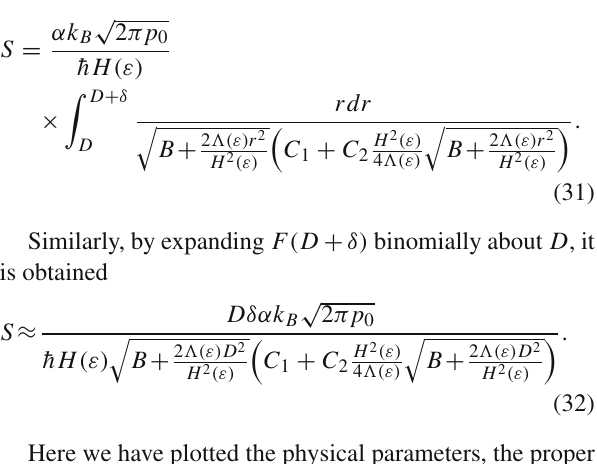
these figures, we see that all three parameters of the shell of gravastar decrease versus the rainbow function H (ε)